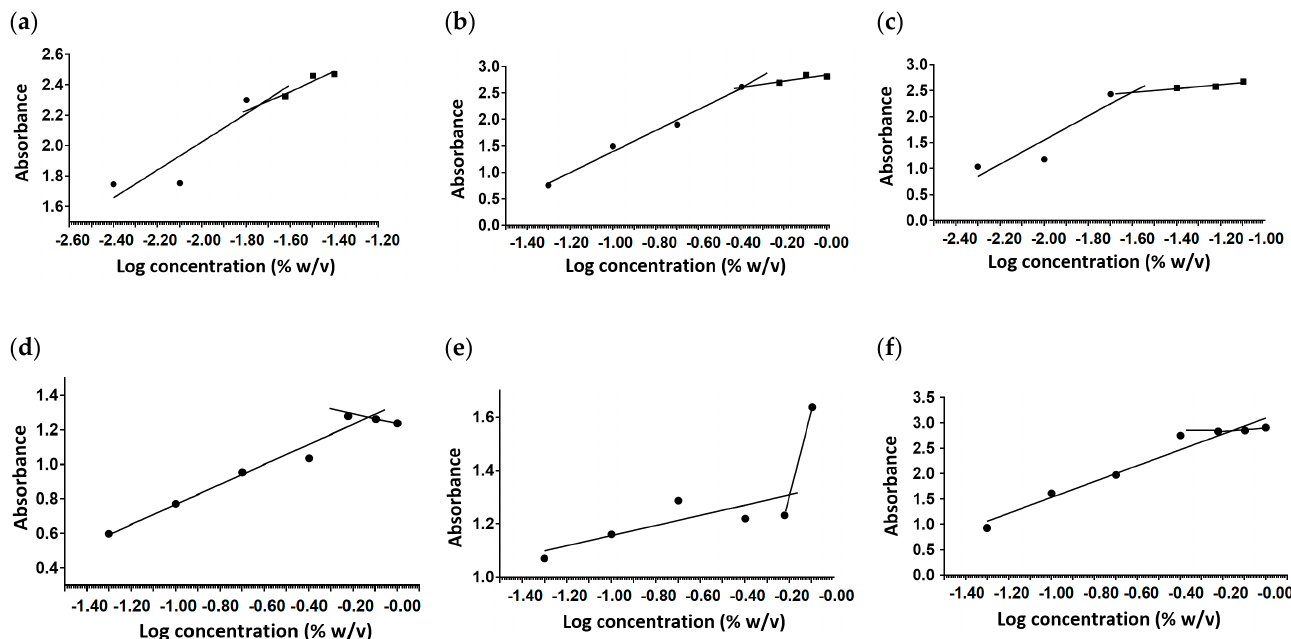
Figure 1. CMC diagram of SDBS ( a ), SDS ( b ), T80 ( c ), HMBS ( d ), HMDS ( e ), and HMT ( f ) using the pyrene fluorescence probe.